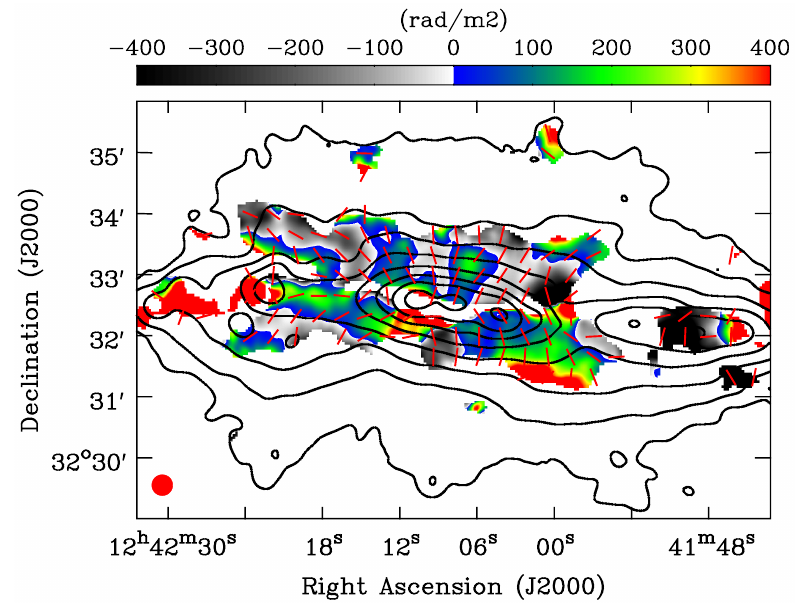
Figure 4. RM map of NGC 4631 in color scale as determined from CHANG-ES C-band (JVLA D-configuration) observations with intrinsic magnetic field orientation with 20.5 (cid:48)(cid:48) HPBW resolution [34]. The total intensity contours are the same as in Figure